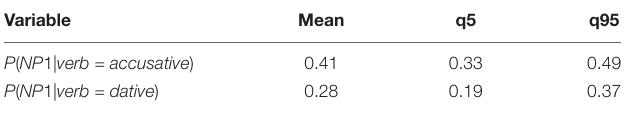
TABLE 2 | Value of P ( NP 1) across verb type for the Expectancy model, Experiment 1. Variable